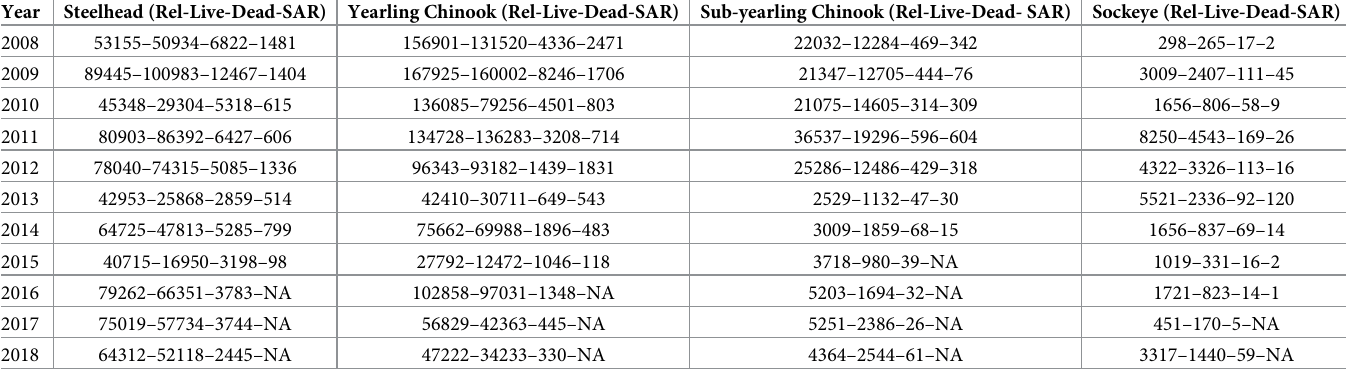
Table 1. Numbers of passive integrated transponder (PIT)-tagged smolts used in this study. Numbers are by species/population and year that were detected/released (Rel) passing Lower Granite Dam; that were subsequently detected/recaptured downstream alive (Live); that were recovered on a bird colony (Dead); or were detected returning as an adult to Bonneville Dam (SAR). NA denotes that complete adult returns were not available. The same fish could be detected multiple times at downstream detection/recapture sites (Live), but only one detection was possible at a recovery site